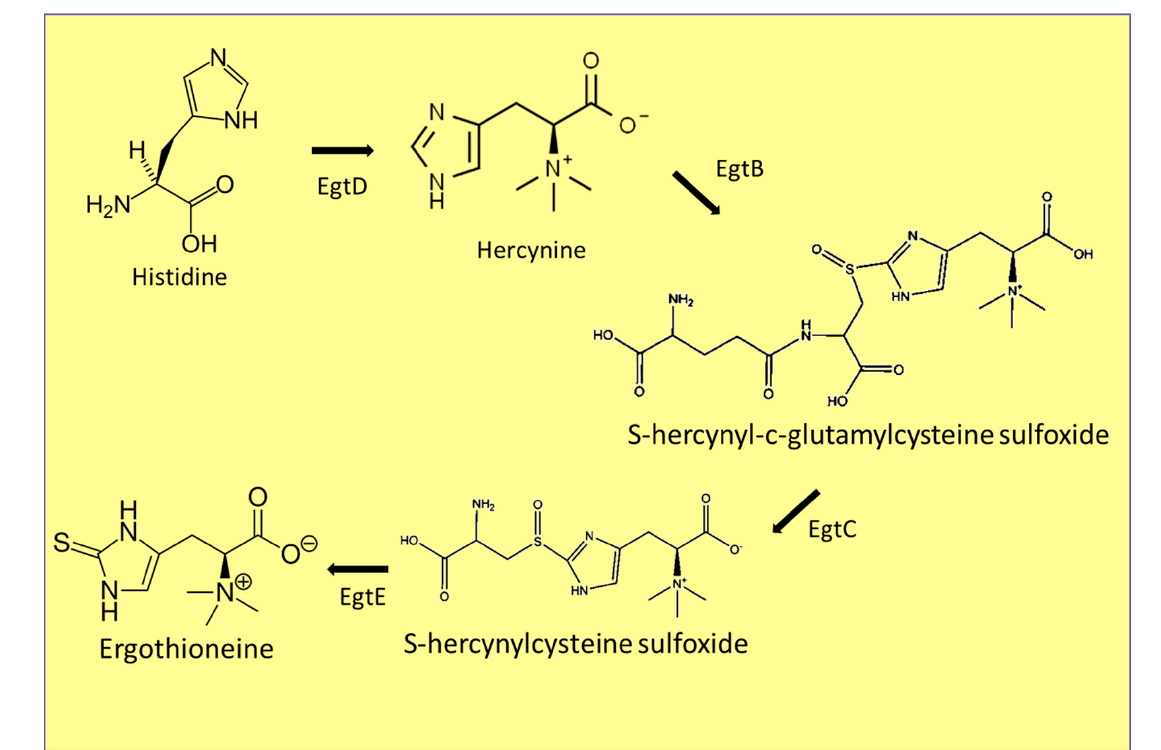
Figure 4. Synthesis of ergothioneine. Ergothioneine biosynthetic proteins EgtB (sulfoxide synthase), EgtC (amidohydrolase), EgtD (methyltransferase), EgtE (hydrolase).